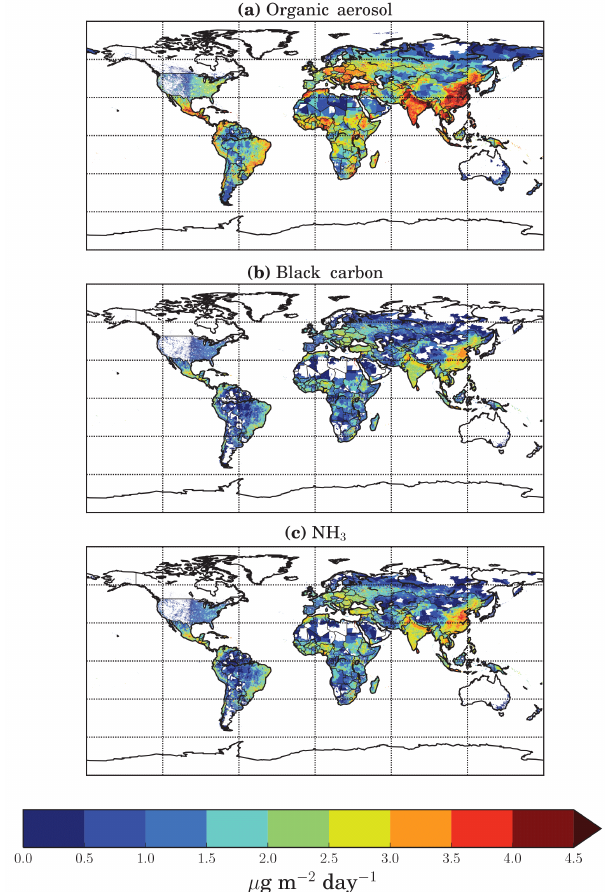
Figure 1. Emission fluxes from the open combustion of domestic waste for (a) organic aerosol, (b) black carbon, and (c) NH 3 from Wiedinmyer et al.